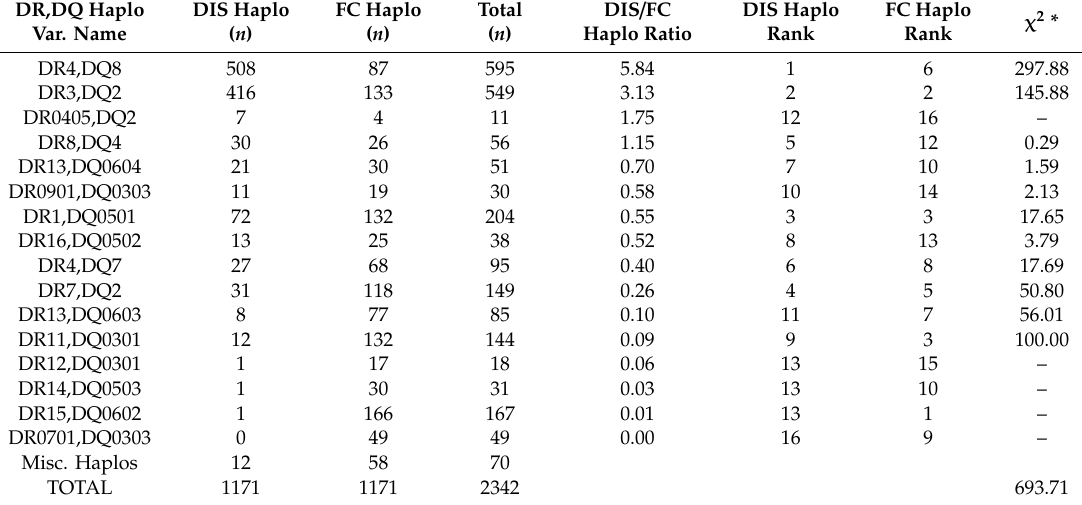
Table 8. Analysis of equalized DIS and FC HLA-DR,DQ haplotypes each ≥ 5 in frequency among overlapping families in both T1DGC studies 1